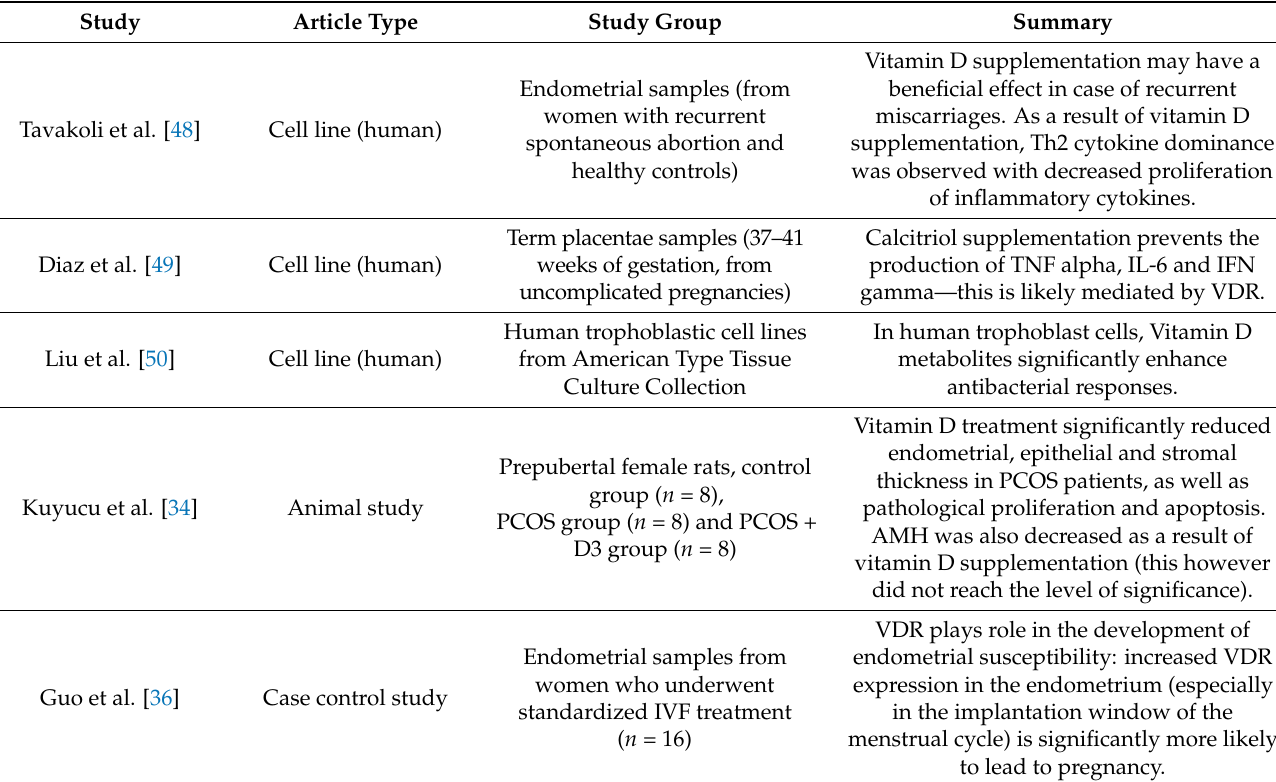
Table 2. Polycystic ovary syndrome and vitamin D